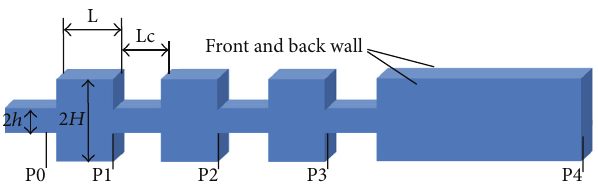
Figure 1: Geometric model of the expansion-contraction microflu- idic